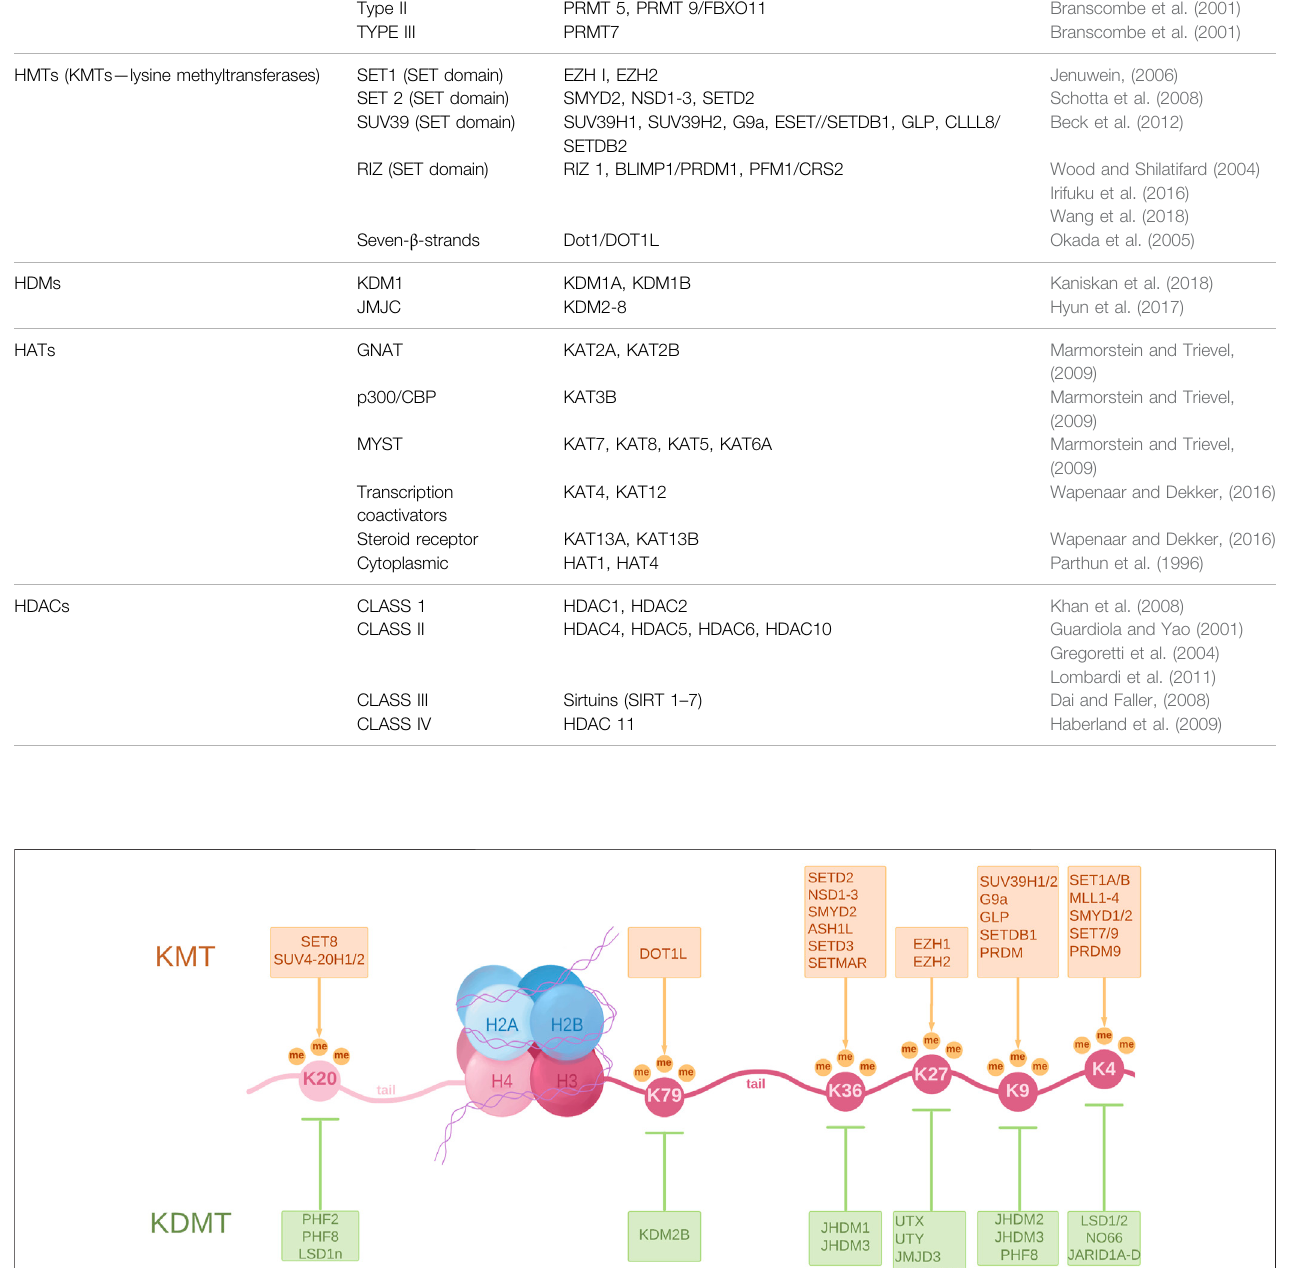
Frontiers in Cell and Developmental Biology |